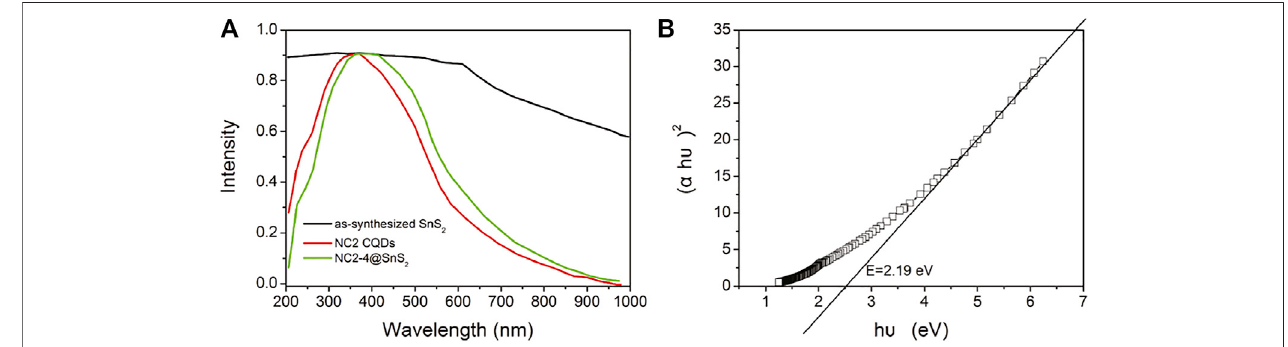
FIGURE 6 | DSR spectra (A) of NC2 CQDs, as-synthesized SnS 2 nanoparticles, and NC2-4@SnS 2 and Tauc plots (B) of as-synthesized SnS 2 .